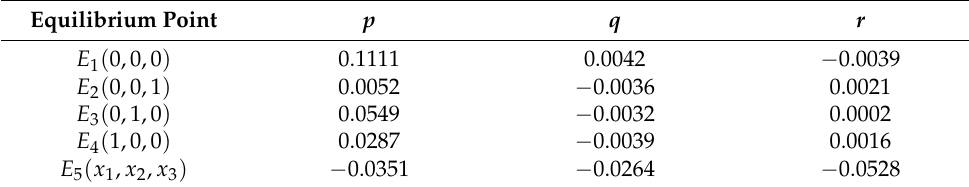
Table 6. Judgment of equilibrium point